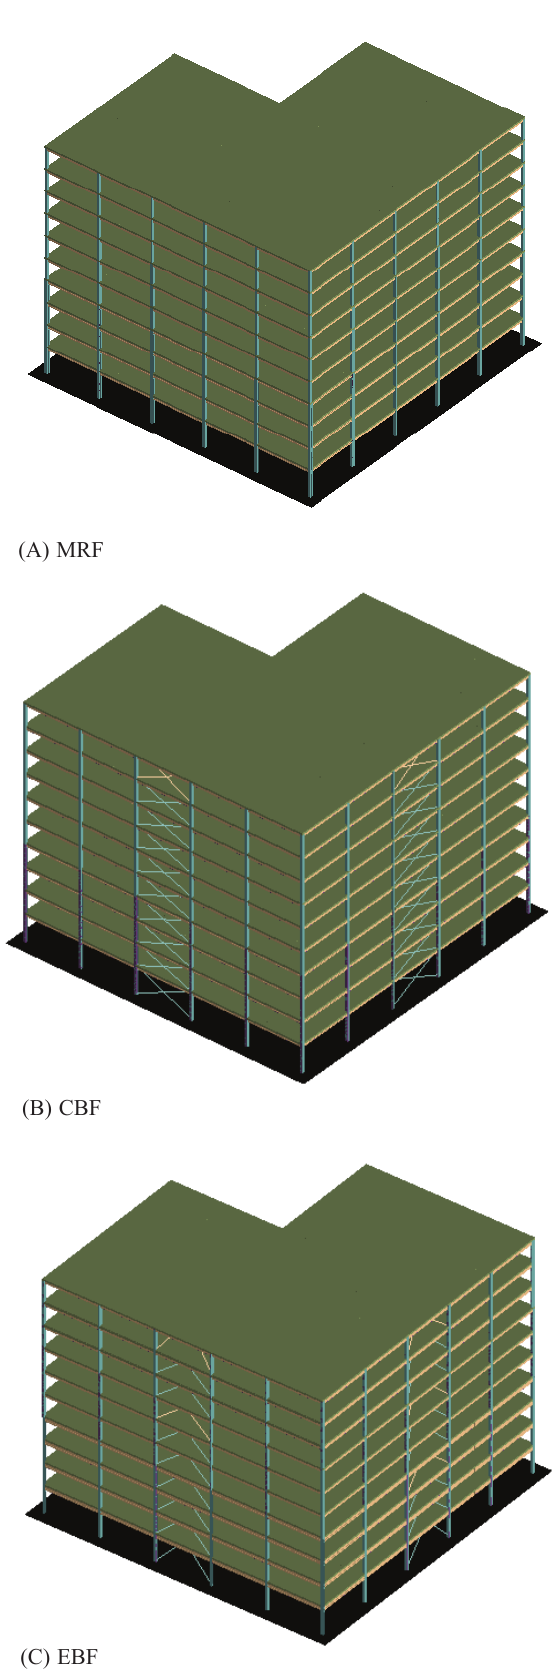
Fig. 1. Horizontally irregular MRF, CBF, and